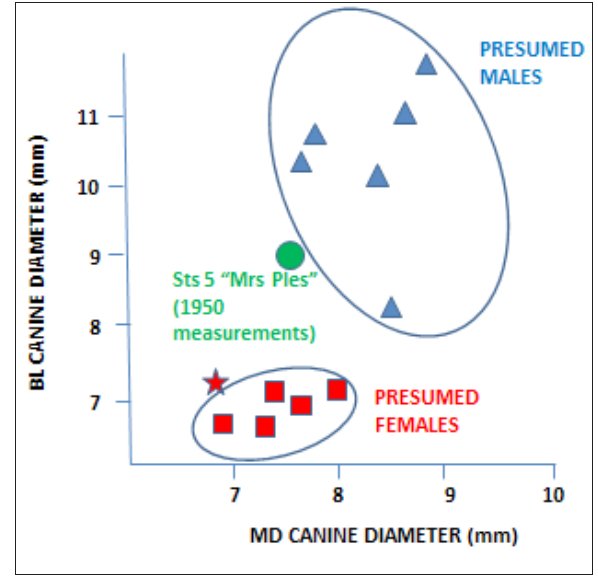
Figure 1: Relationship between buccolingual (BL) and mesiodistal (MD) diameters for conical canine sockets, based in part on data for presumed male individuals (blue triangles) and presumed female individuals (red squares) of Australopithecus africanus , published by Grine et al. 11 The green circle represents MD and BL measurements for Sts 5 as published by Broom et al. 12 , most probably taken before damage and alveolar bone loss occurred. According to these data, Sts 5 is more likely to belong to a small male individual than a female individual, as proposed by Grine et al. 11 The red star represents measurements of Sts 5 given by Grine et al. 11 , probably obtained after damage caused by digestion of cranial bone in acetic acid. Presumed male individuals are Stw 505, TM 1511, Sts 52, Stw 183, Stw 252, Stw 369 and presumed female individuals are Sts 71, Sts 17, Sts 53, Stw 13, Stw 73. 11